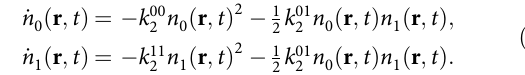
Magnetic fi eld dependence . The single-channel model has no explicit dependence on magnetic fi eld, but at fi elds below 98.8 G the initial state is no longer the lowest in energy. If hyper fi ne- changing collisions were a signi fi cant source of loss in the ground state, we would expect the loss rate to rise at lower fi elds. Con- versely, if the loss is entirely mediated by the formation of col- the energy of the asymptotic states and the loss rate will be independent of magnetic fi eld.